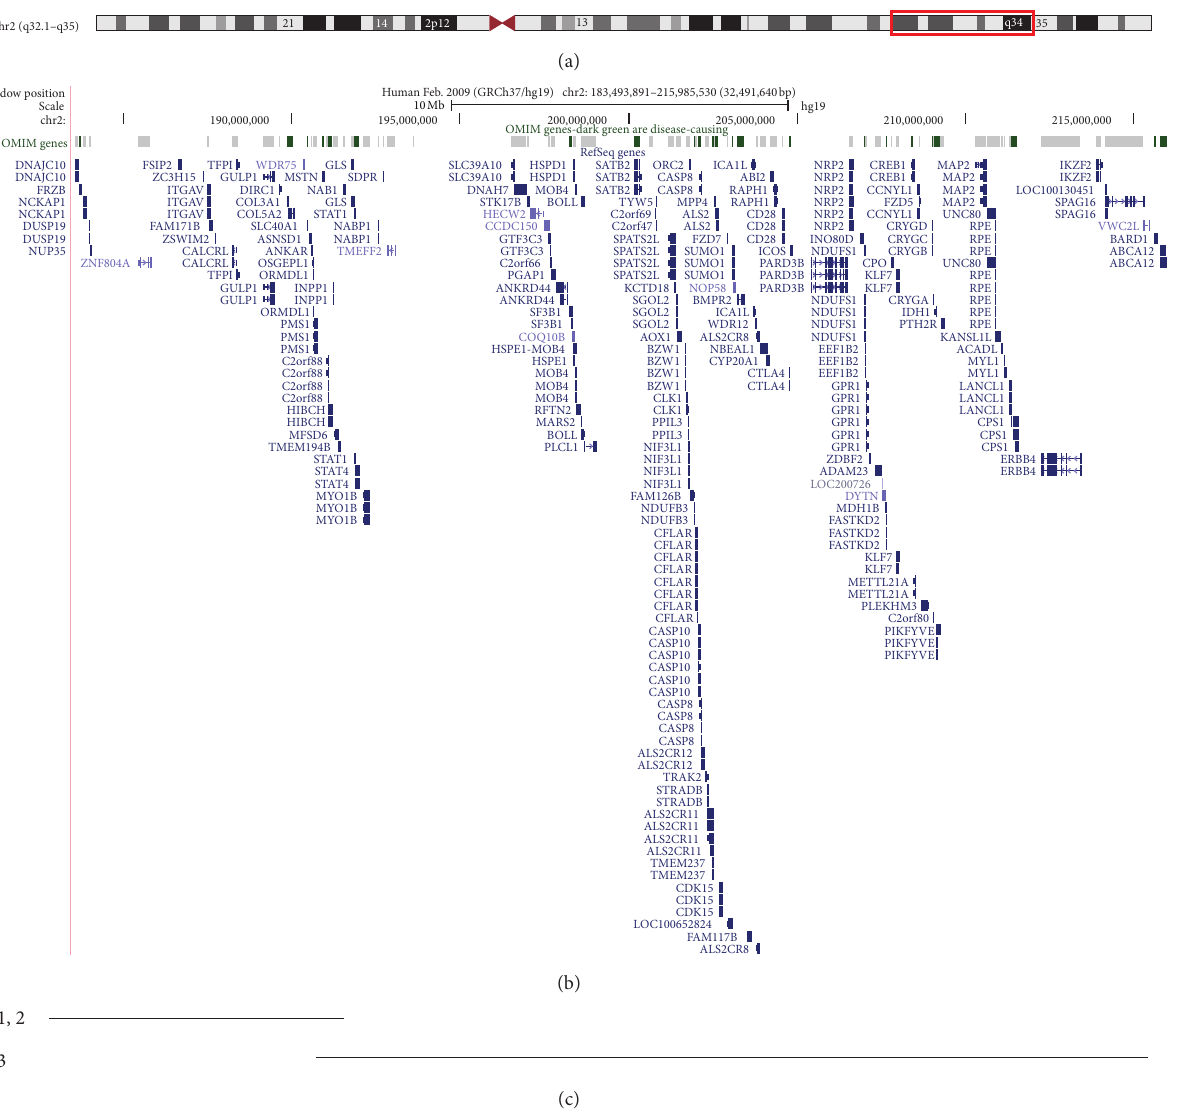
Figure 2: Schematic of the chromosome 2 region encompassing the deletions detected in the patients reported here. Panel (a) shows an ideogram of chromosome 2. Panel (b) shows the OMIM genes and RefSeq genes that lie in the region of the deletions reported here. Panel (c) shows the location and extent of the deletions for patients 1, 2, and 3. The images in panels (a) and (b) are taken from the UCSC genome browser